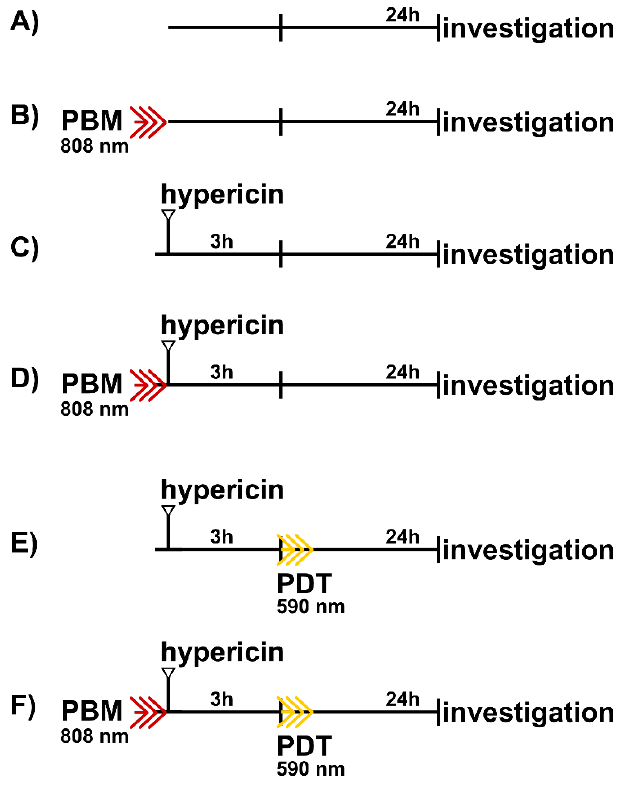
Figure 1. Schemes of therapeutical protocols: ( A ) control, ( B ) PBM, ( C ) hypericin in dark, ( D ) PBM- hypericin, ( E ) hypericin-PDT, and ( F ) PBM-hypericin-PDT. ( D ) PBM-hypericin, ( E ) hypericin-PDT, and ( F )